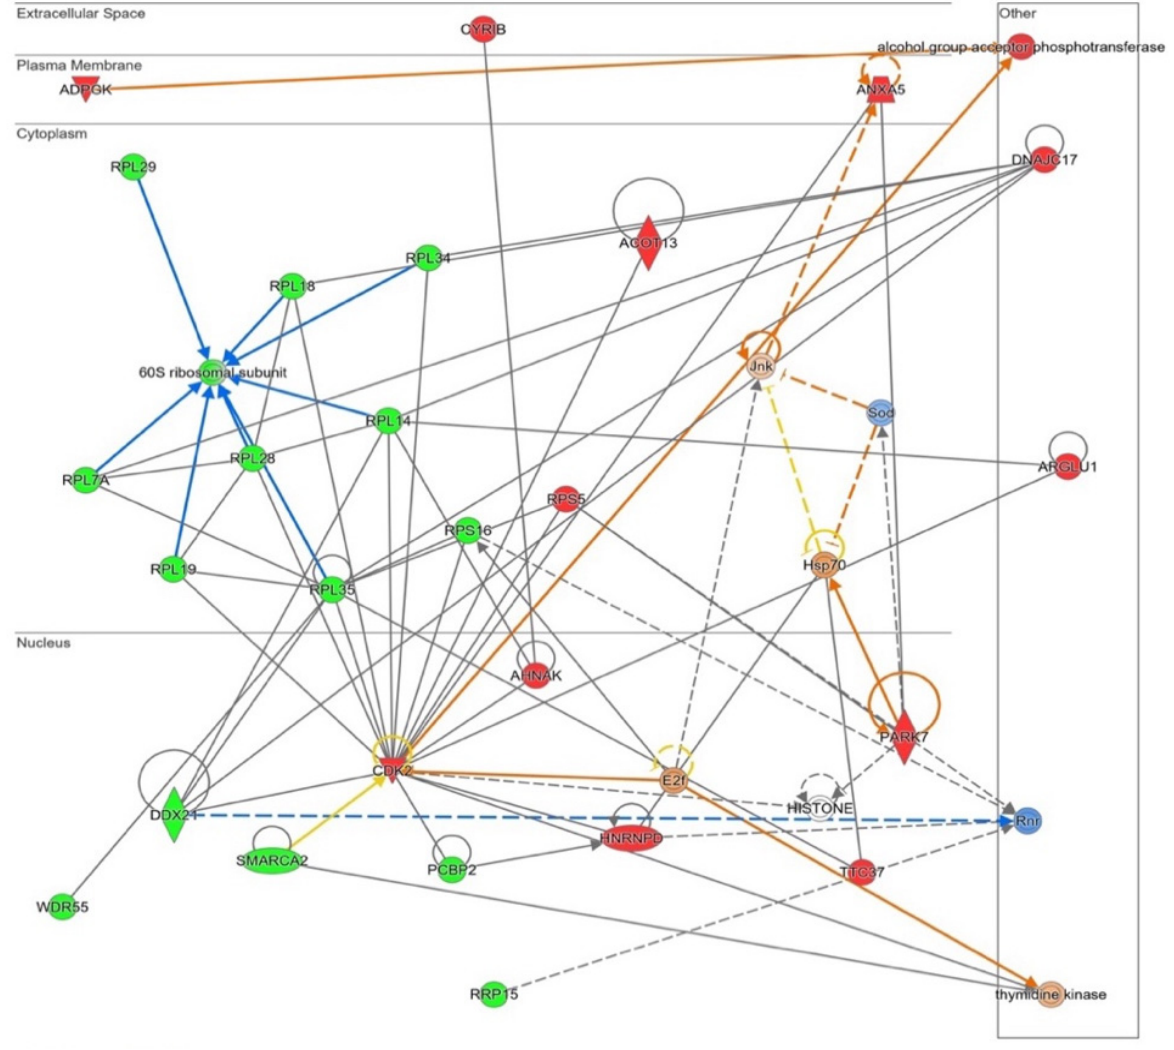
Figure 6. Functional network altered by NOX5- β overexpression in hCMEC/D3 cells related with cell proliferation and apoptosis (inferred from Ingenuity ® software). The network contains Cyclins signaling proliferative pathway, including ribosome proteins downregulation. Proteins are represented in different subdivisions of the scheme according to their cellular location (nucleus, cytoplasm, plasma membrane, extracellular space, or other). Green: indicates decreased expression measurement. Red: indicates increased expression measurement. Blue lines: predicted inhibition. Orange lines: predicted activation. Grey/White lines: non-predicted effect. Yellow lines: findings inconsistent with the estate of downstream molecule. Color intensity directly associates with statistical confidence for orange and blue objects. Potential master regulators identified: E2f and Hsp70 (activated) and ribonucleotide reductase (Rnr) (inhibited).